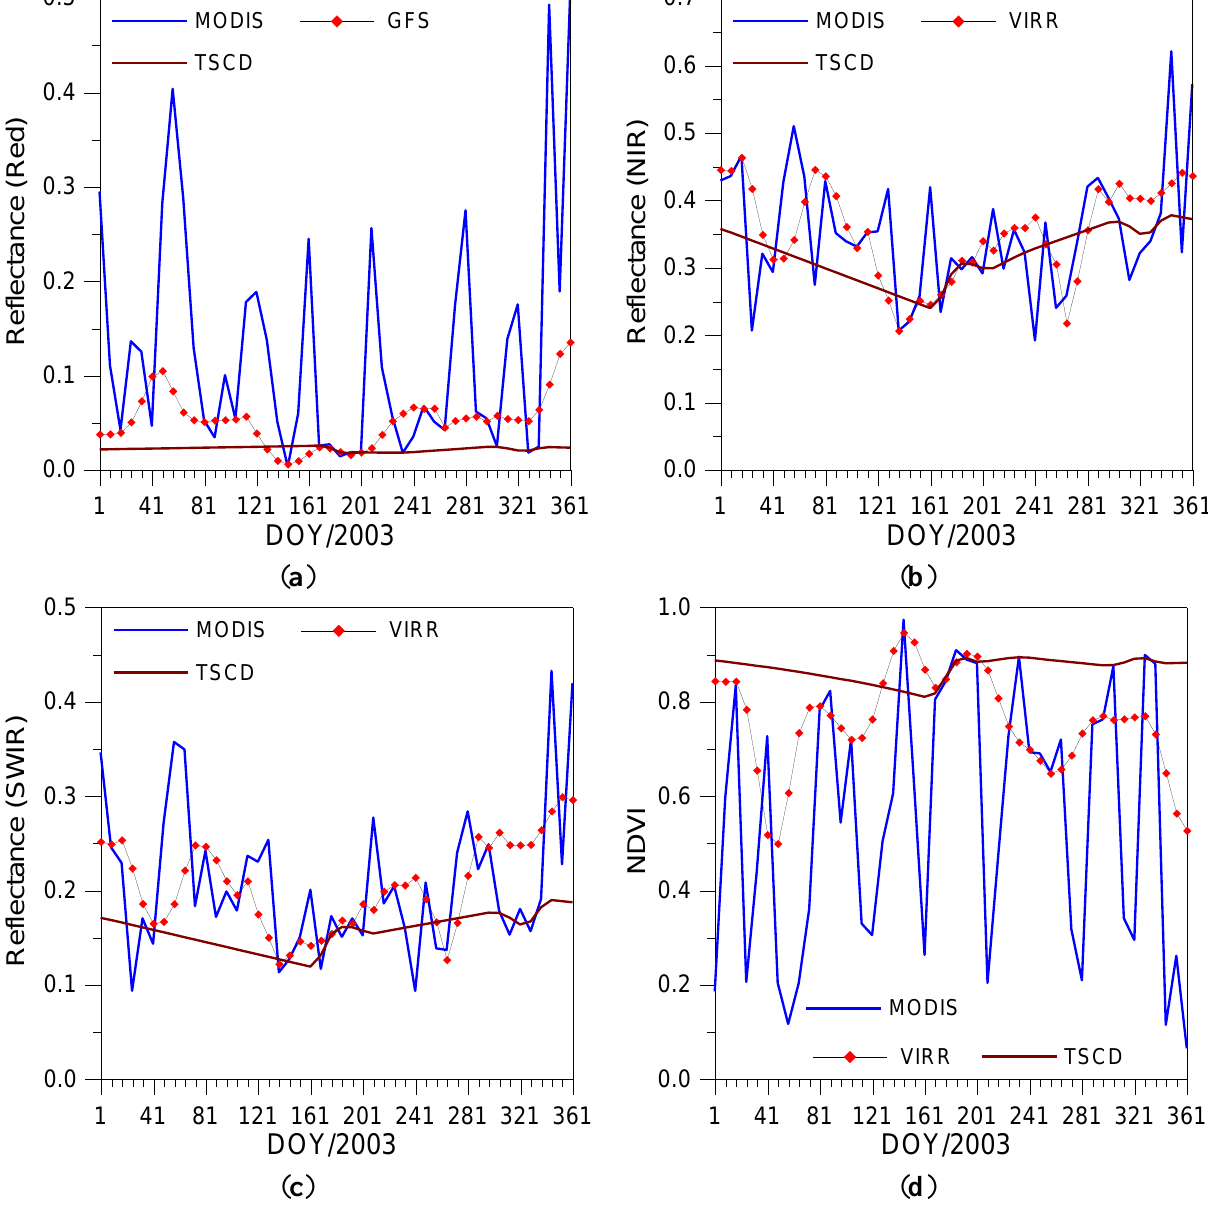
Figure 10. Time series of surface reflectance and NDVI from MOD09A1, the VIRR and TSCD algorithms for the center pixel of the Tapajos site in 2003. ( a ) surface reflectance in the red band; ( b ) surface reflectance in the NIR band; ( c ) surface reflectance in the SWIR band; ( d )